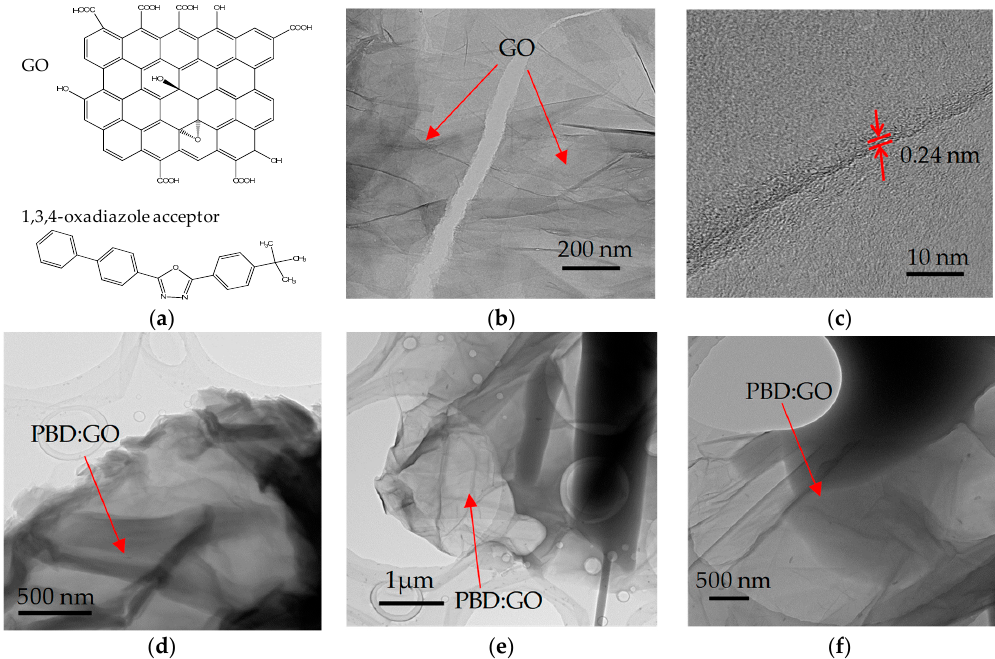
Figure 1. Micrographs of graphene oxide (GO) and 2-tert-butylphenyl-5-biphenyl-1,3,4-oxadiazole (PBD):GO nanocomposites. ( a ) Structure of 1,3,4-oxdiazole acceptor and a schematic representation of multilayers of GO; ( b ) Transmission electron microscope (TEM) and ( c ) High-Solution TEM micrographs of GO sheets; ( d – f ) TEM images of PBD:GO nanocomposite with distinct weight ratio 2:1, 5:1, 10:1 (w/w).